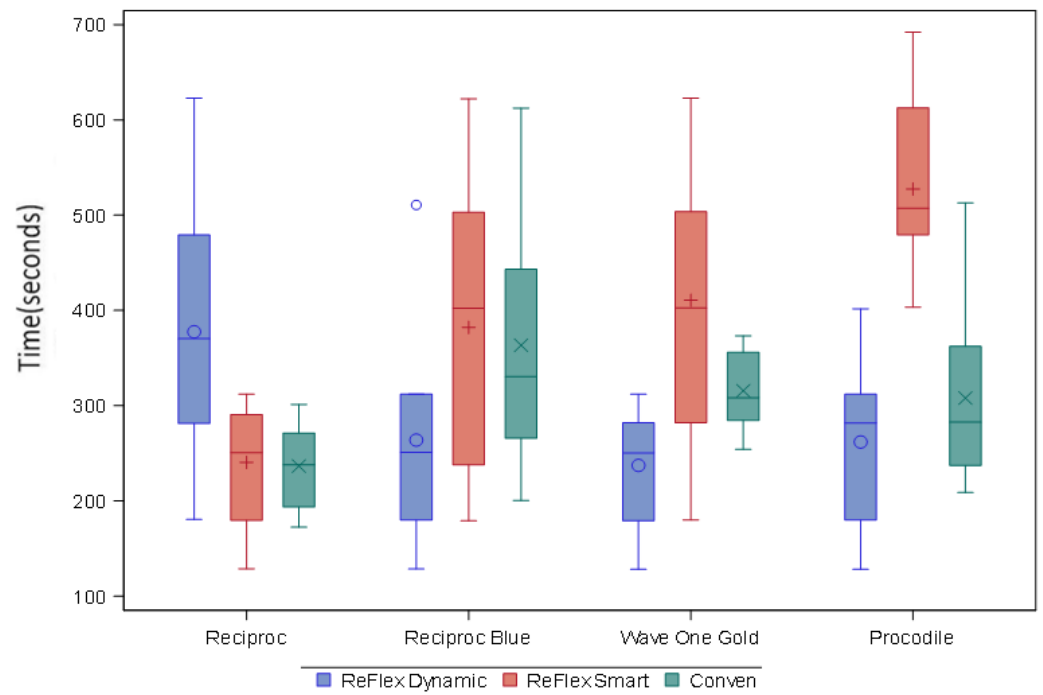
Figure 3. Graph of time of fracture of different system files and movements.